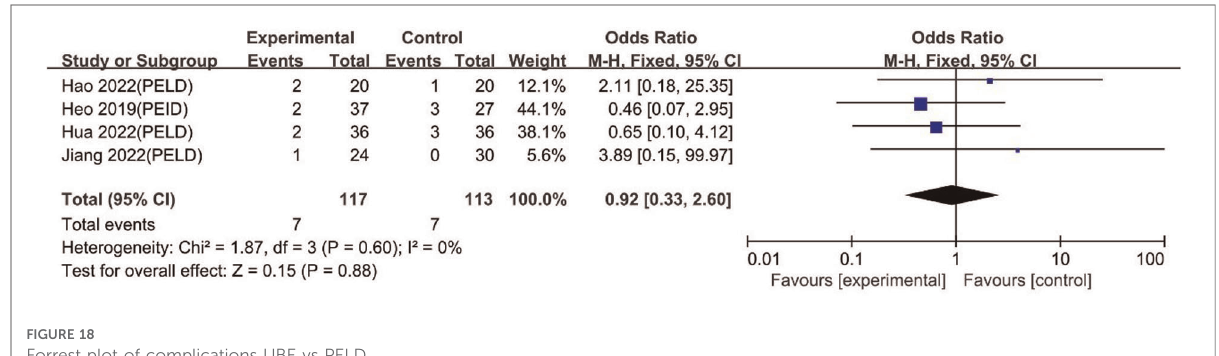
FIGURE 18 Forrest plot of complications UBE vs